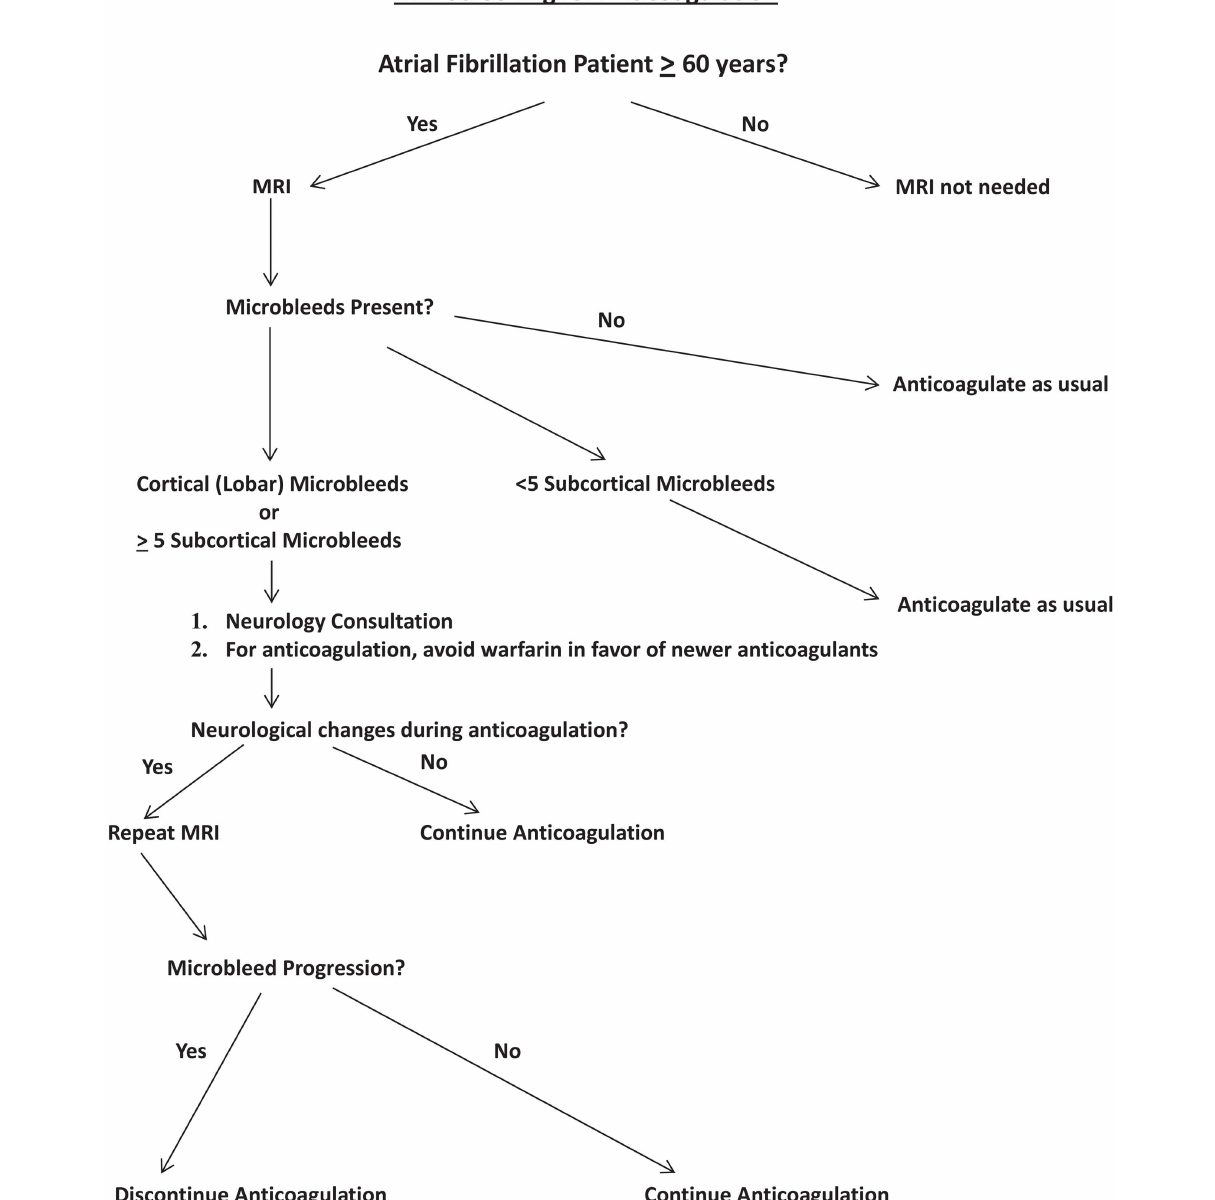
Frontiers in Neurology |